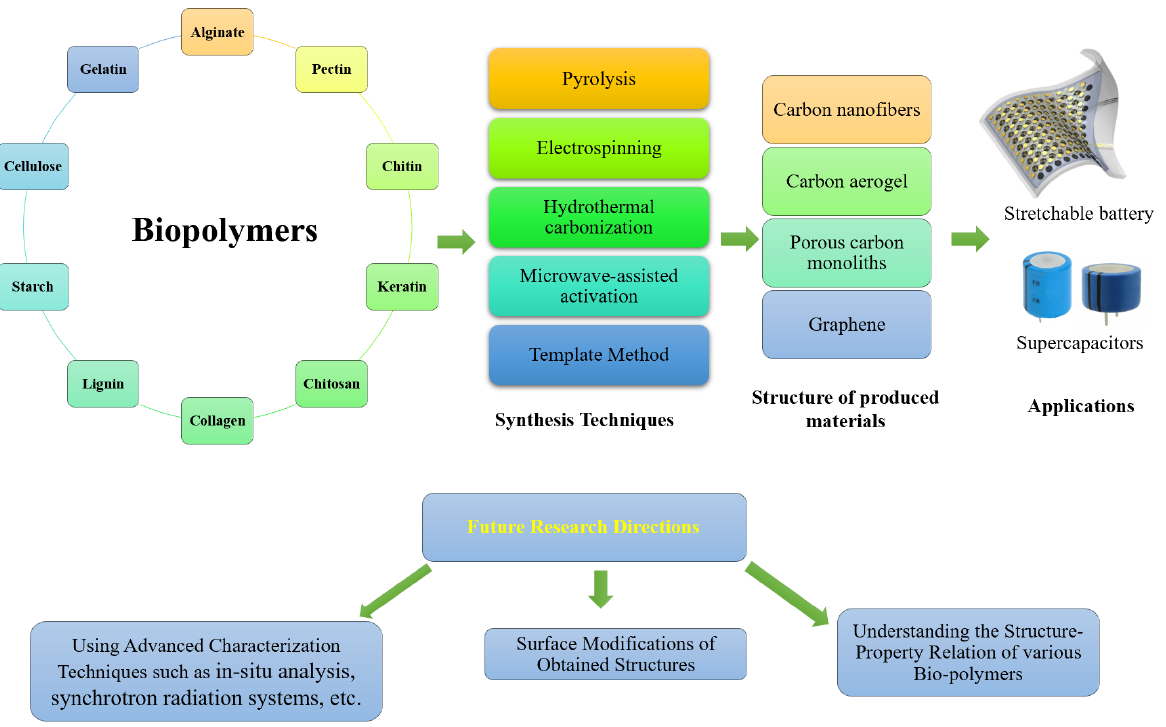
Figure 18. Summary of the various bio-polymers, synthesis, produced structures, applications, and future research directions.